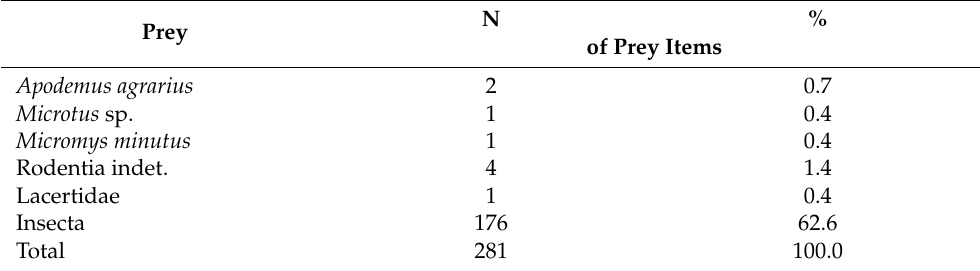
Table A3. Cont. Prey